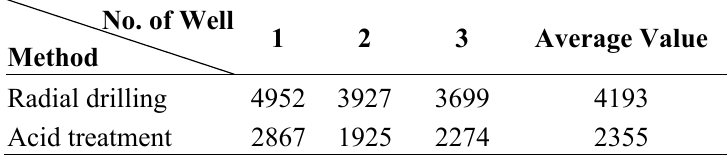
Table 6. Additional oil production as a result of the hydrodynamic modeling